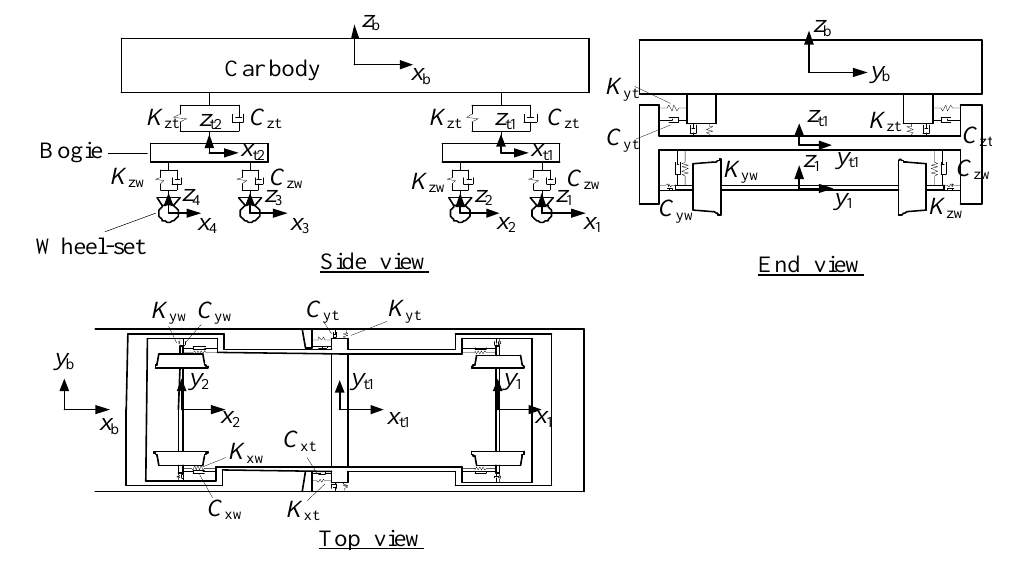
Figure 14. The 31-DOF model of a carriage.